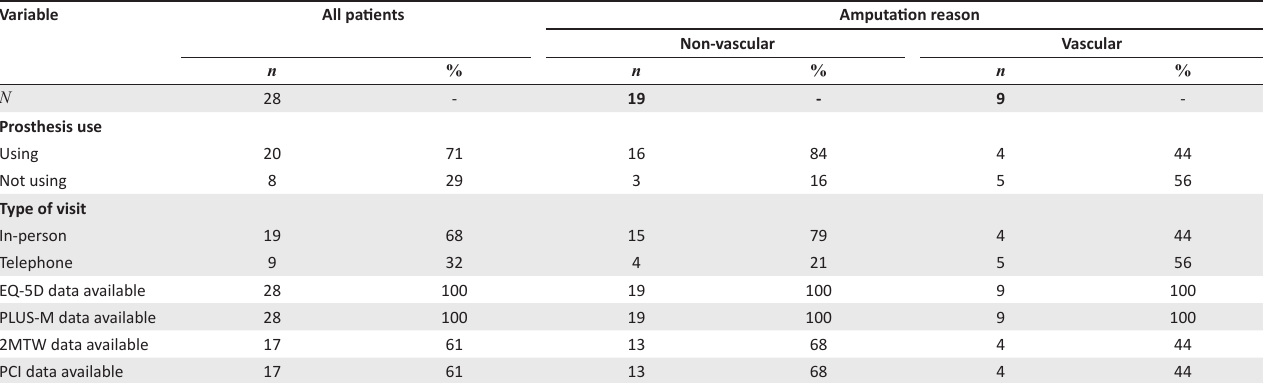
TABLE 2-A1: Data information for 12-month follow-up.